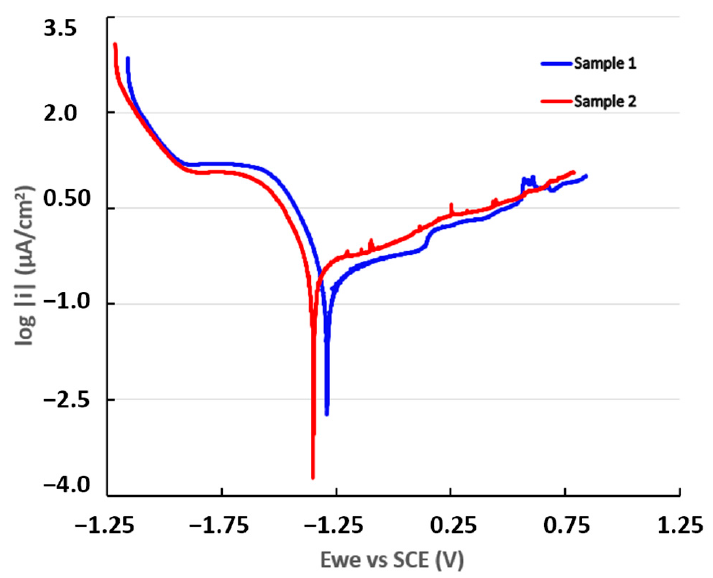
Figure 5 . Potentiodynamic polarization curves for Sample 1 and Sample 2. Figure 5. Potentiodynamic polarization curves for Sample 1 and Sample 2.